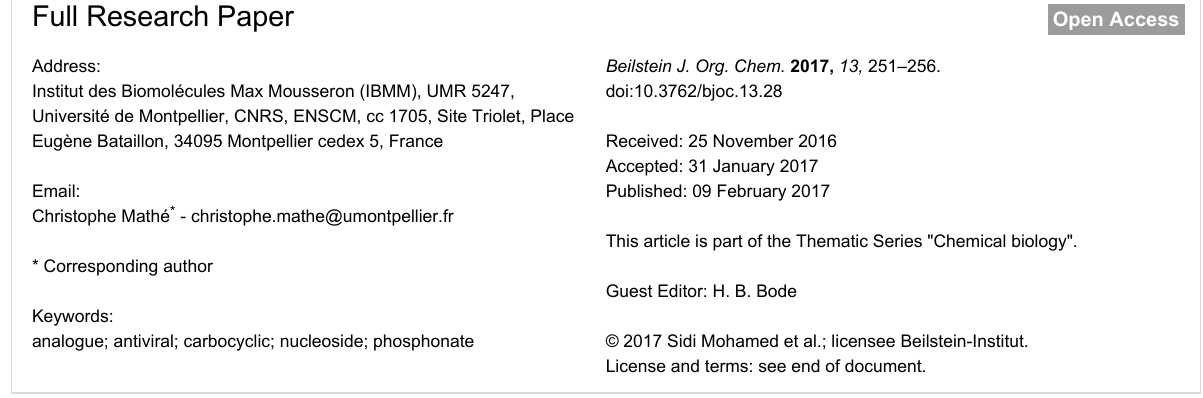
(Figure 1) bearing purine bases (adenine and guanine) in order to evaluate their antiviral